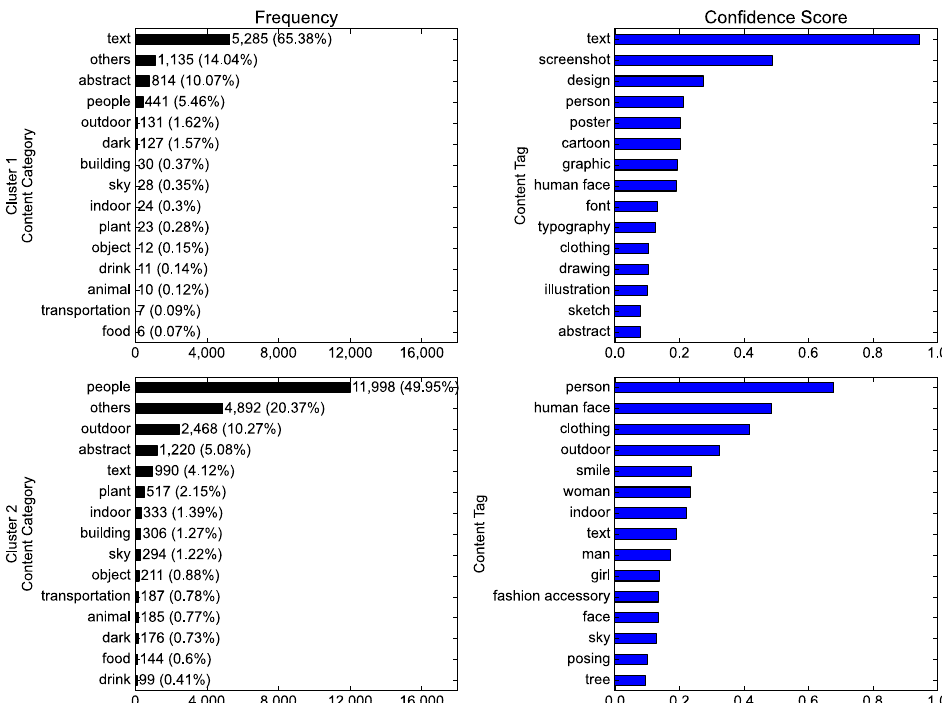
Figure 4. The comparison between clusters (upper vs. lower rows) of the Instagram photos with a #NoMask hashtag in terms of the content: the frequency of photos by content category (left column), and the content tags with the highest mean confidence scores (right column).